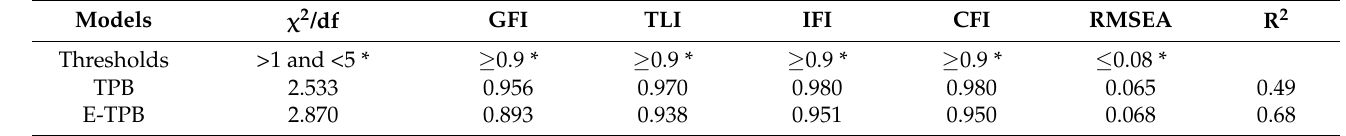
Table 5. Goodness-of-fit indices and explanatory power of two models.